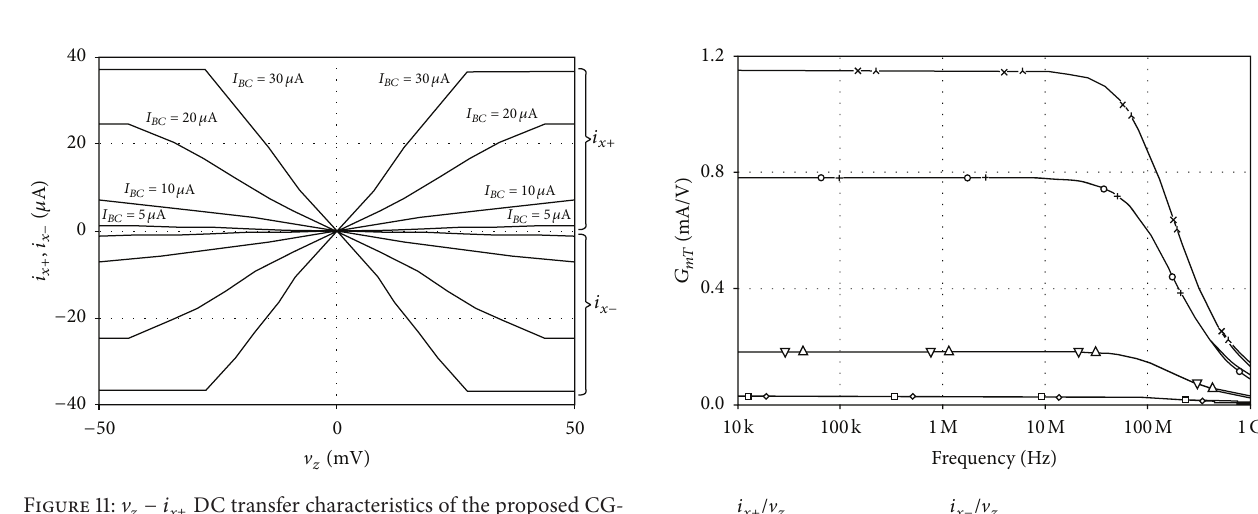
Figure 11: V 𝑧 − 𝑖 𝑥± DC transfer characteristics of the proposed CG- CFTA for different values of 𝐼 𝐵𝐶 .